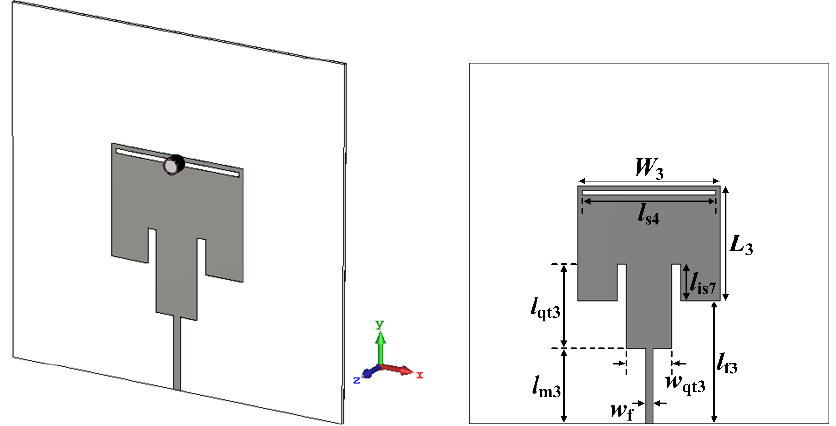
Figure 15. Geometry of the quarter ‐ wave transformer ‐ added scaled RS ‐ loaded MPA with the liquid container for liquid MUTs with high relative permittivity and high loss tangent.